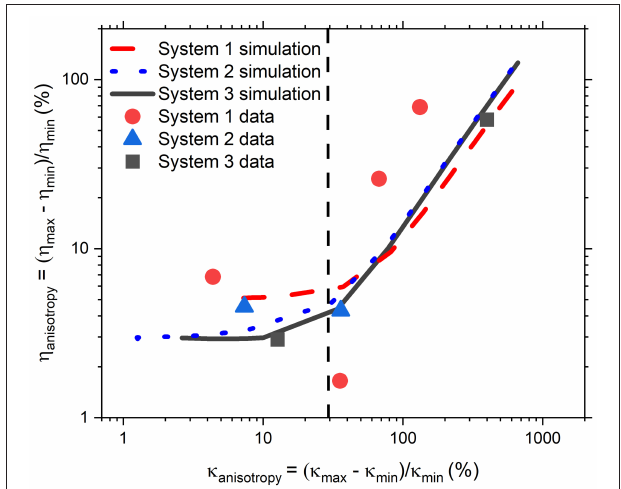
FIGURE 5 | Anisotropy in η as a function of anisotropy in κ from experiments (filled symbols) and simulations (lines). Simulations were carried out to match the frame rate, temperature, bead size, and run length of the data from System 1 (experimental results red circles, simulations red dashed line), System 2 (experimental results blue triangles, simulations blue dotted line), and System 3 (experimental results black squares, simulations black solid line). Black dashed line is a rough judge of the level below which anisotropy in κ will have a discernible effect on the anisotropy in η